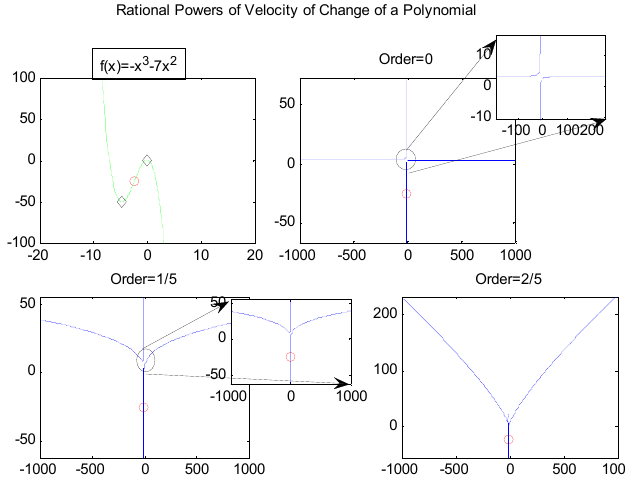
Figure 7. The rates of change for f ( x ) = x 3 − 7 x 2 orders {3/5, 4/5, 1}.